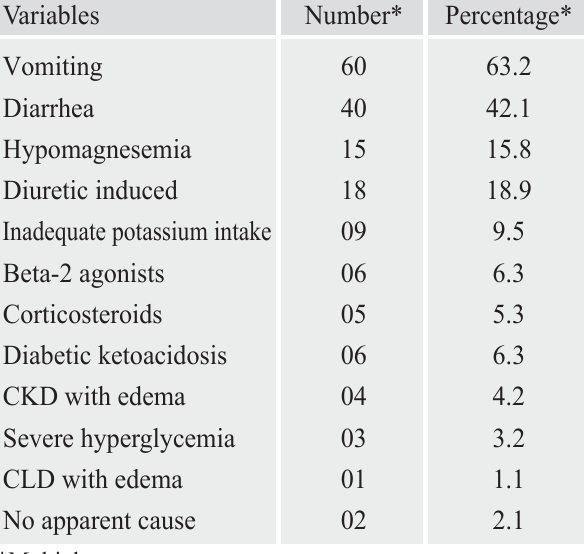
Congestive cardiac failure. Axis values are in percentage.